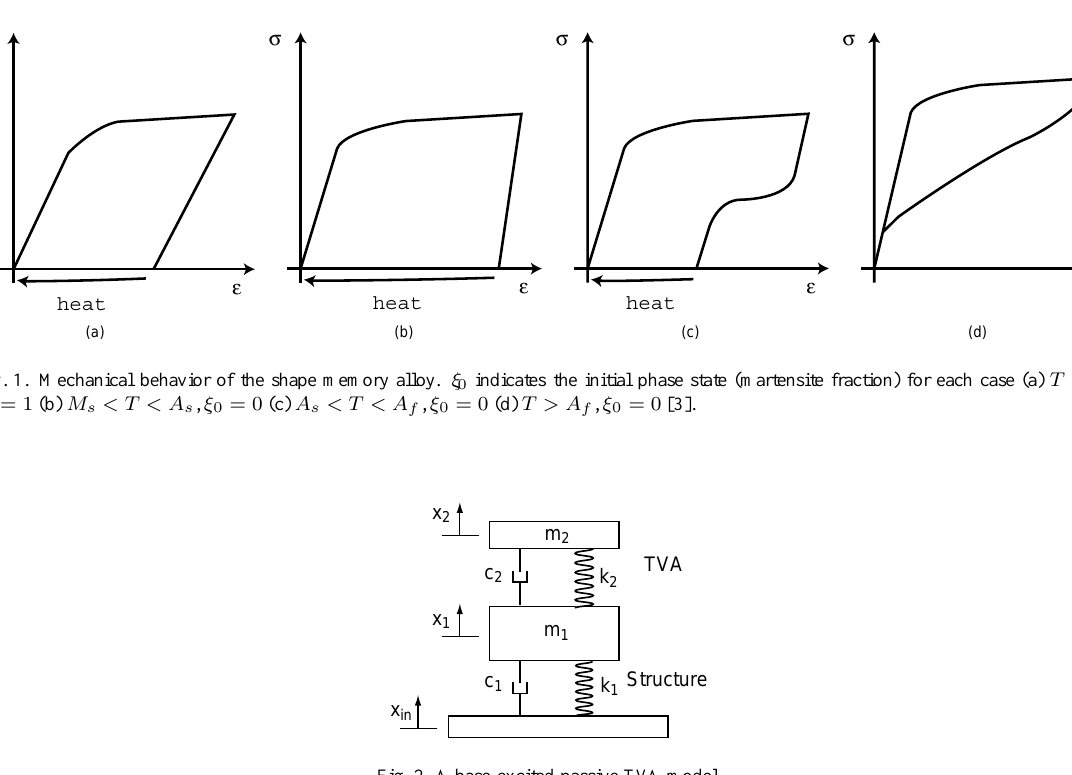
Fig. 2. A base-excited passive TVA